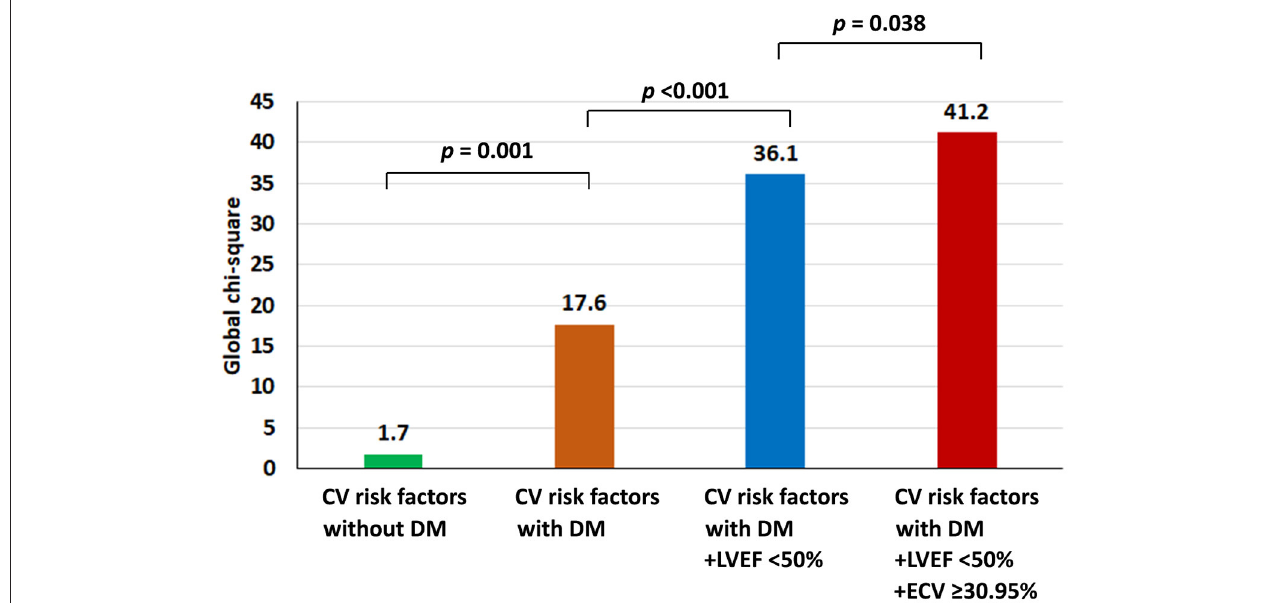
FIGURE 2 | Incremental prognostic value shown as global chi-squared value compared among patients with type 2 diabetes (T2D); patients with T2D and left ventricular ejection fraction (LVEF) < 50%; and patients with T2D, LVEF < 50%, and extracellular volume fraction ≥ 30.95%.